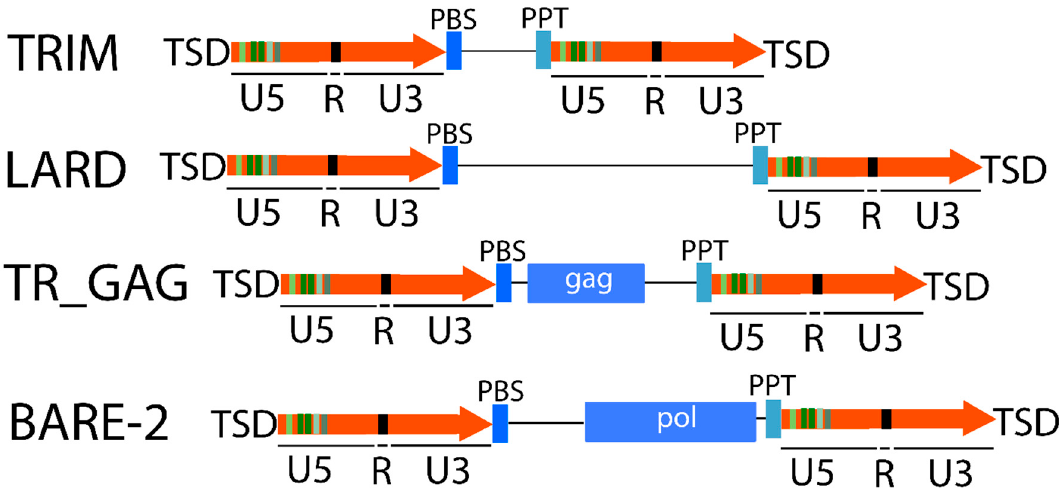
Figure 2. Structure of non-autonomous elements. Orange arrows correspond to LTRs and single lines correspond to non-coding regions. PBS: primer binding site; PPT: Poly-Purine Tract; TRIM: Terminal-Repeat Retrotransposons in Miniature; LARD: LArge Retrotransposon Derivatives.